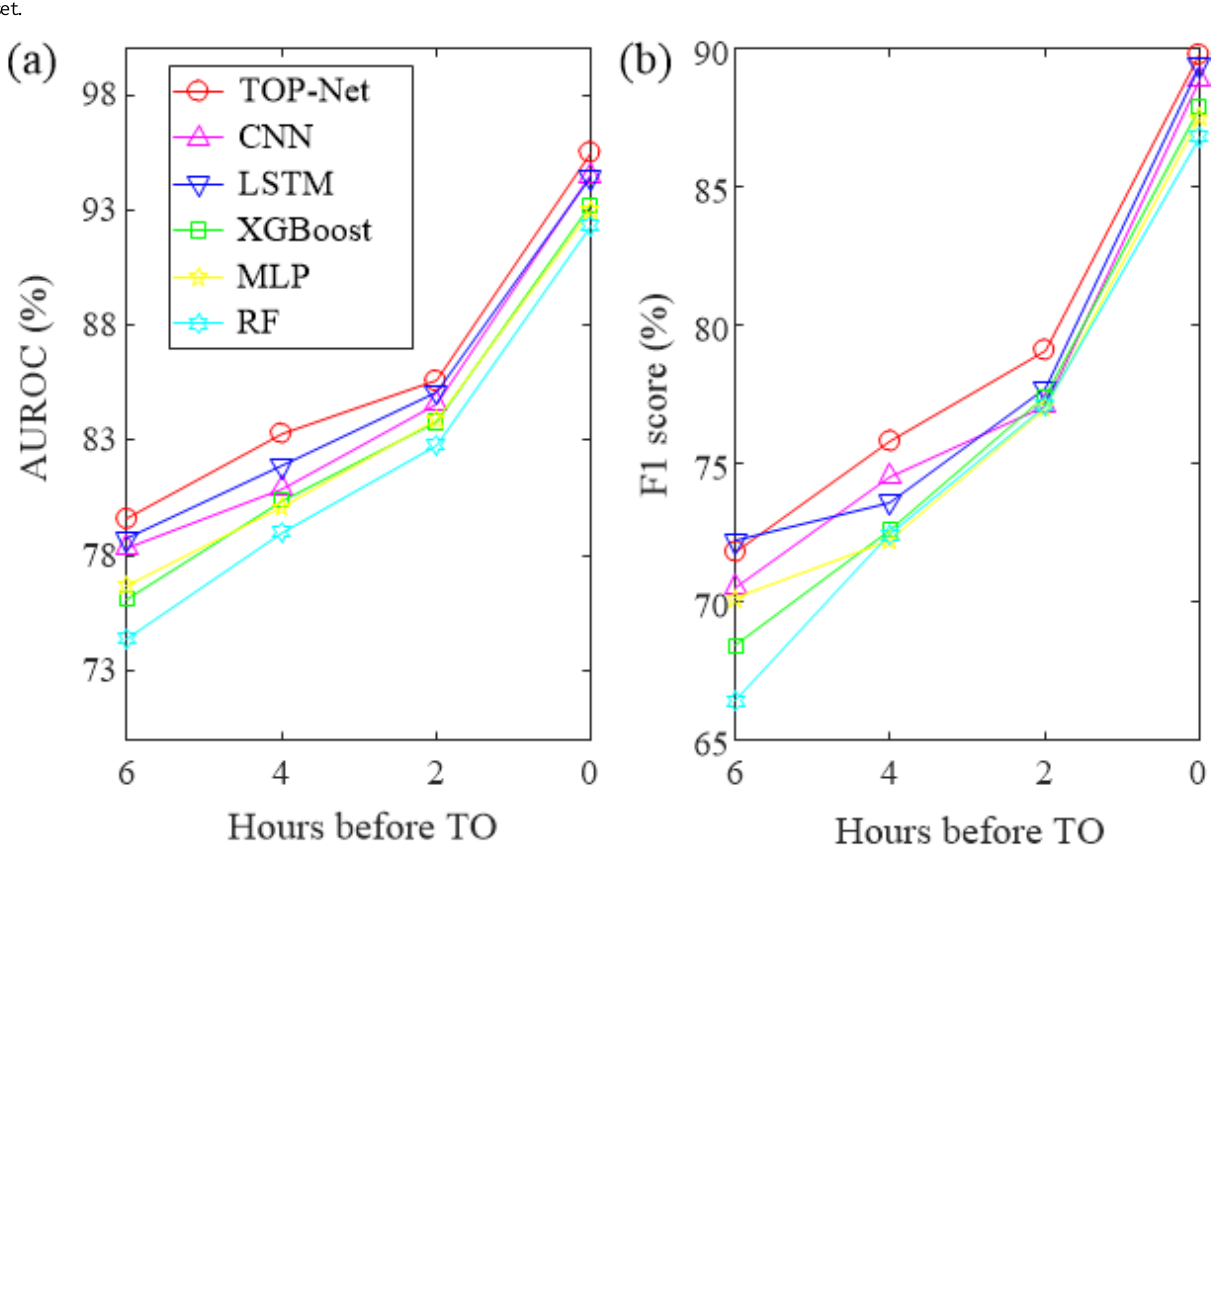
Figure 7. TOP-Net performance: (a) AUROC and (b) F1 score. AUROC: area under the receiver operating characteristic curve; CNN: convolutional neural network; LSTM: long short-term memory; XGBoost: extreme gradient boosting; MLP: multilayer perceptron; RF: random forest; TO: tachycardia